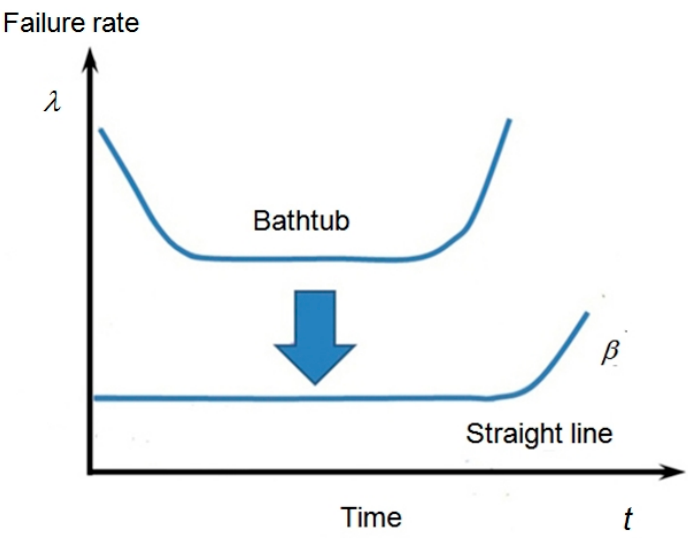
Figure 3. Bathtub curve and straight line with slope β .